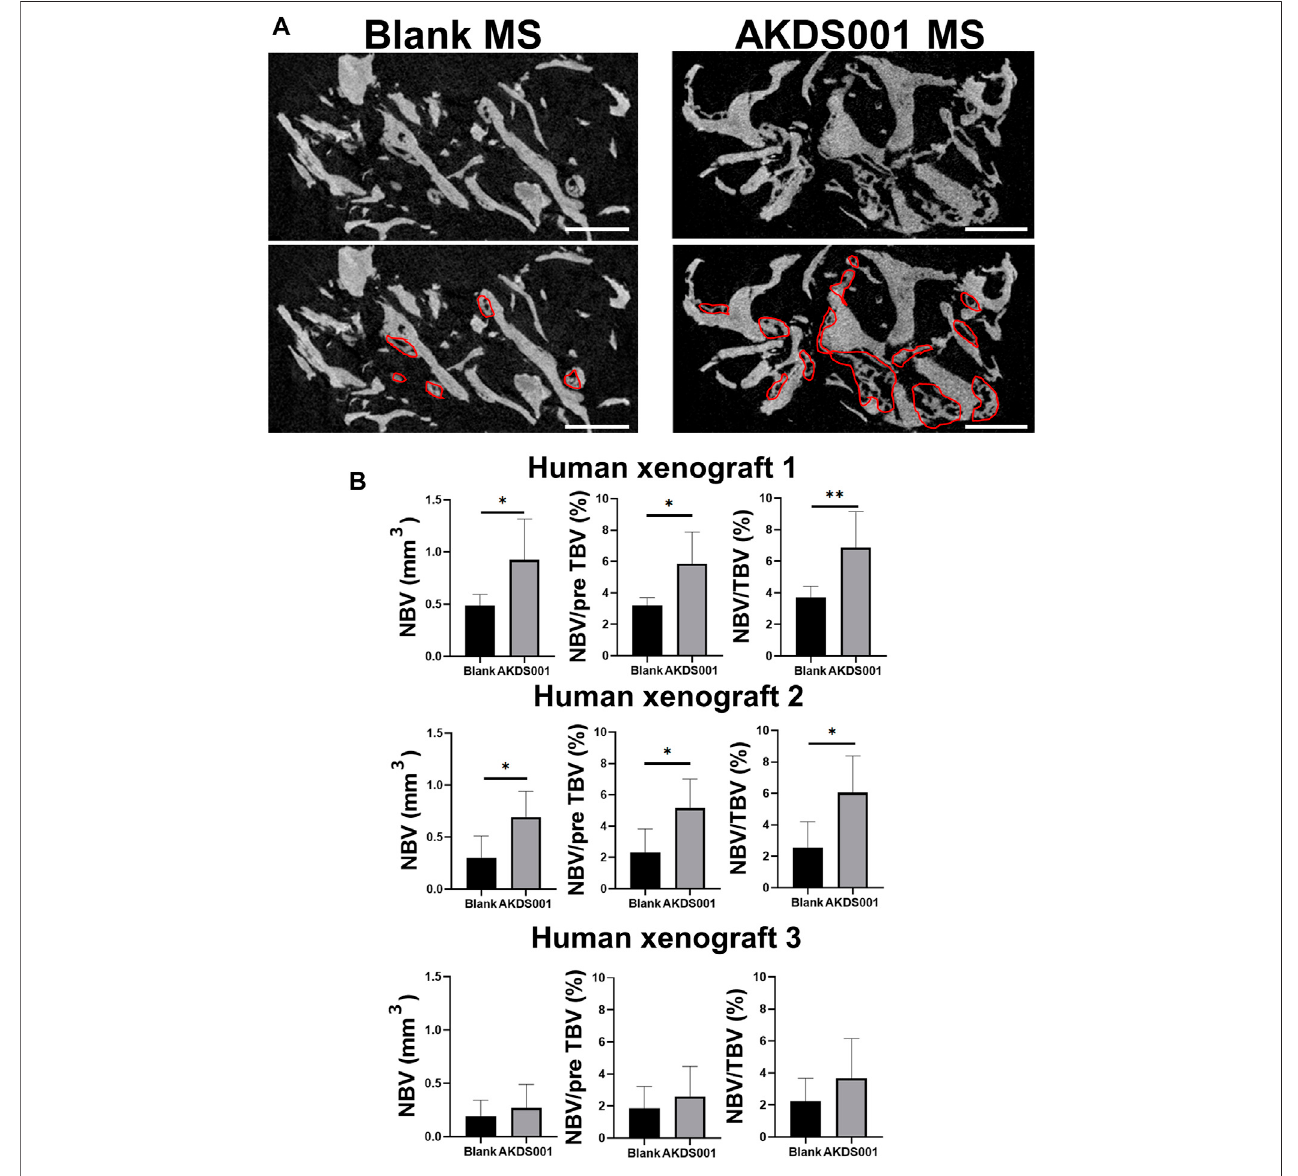
FIGURE 3 | Microcomputed tomography ( μ CT) analysis of extracted bone. (A) Representative μ CT images. Scale bars, 1 mm. The areas circled with red lines indicate new bone. (B) New bone volume (NBV), NBV/preoperative total bone volume (pre TBV) and NBV/total bone volume (TBV) were calculated for human